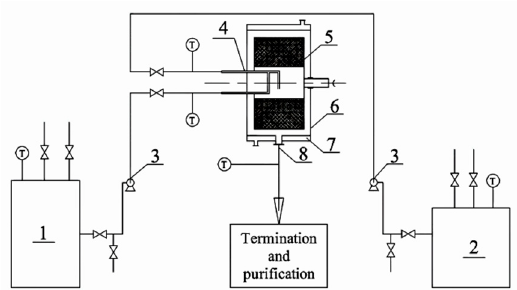
Figure 1. Schematic diagram of the experimental set-up for the polymerization of IB in RPB: 1—a tank for the solution of IB, 2—a tank for the solution of the initiating system, 3—metering pumps, 4—liquid inlets and distributors, 5—the packed rotator, 6—the fixed casing, 7—the jacket for coolant, 8-the liquid outlet.